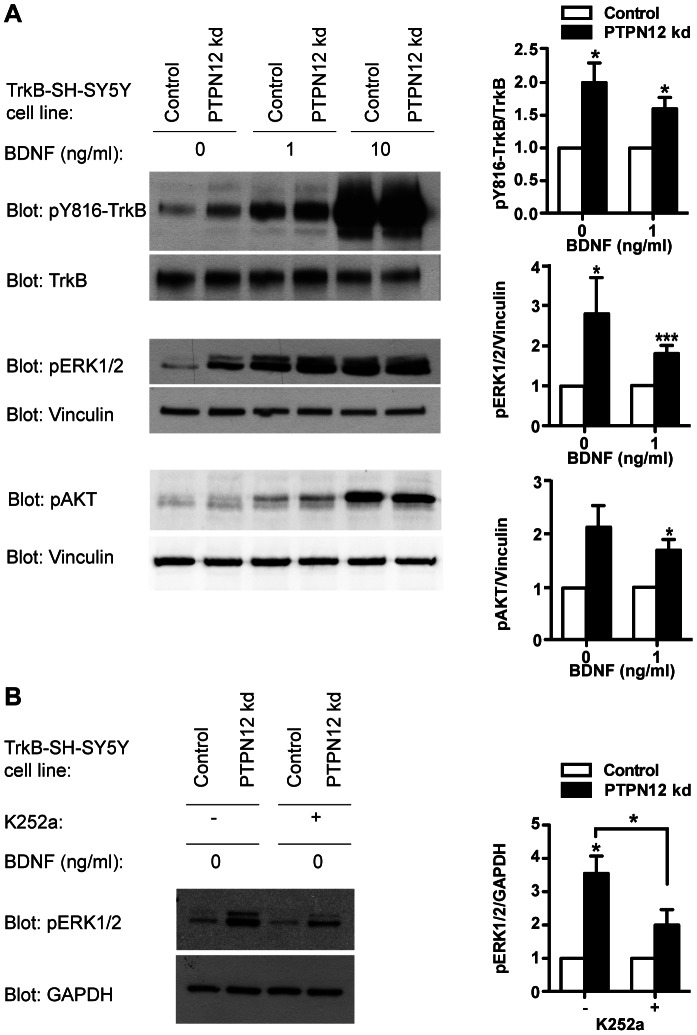
PTPN12 modulates TrkB signaling in TrkB-SH-SY5Y cells.A) Western blot analyses for pY816-TrkB, TrkB, pERK1/2, pAKT and Vinculin levels in control and PTPN12 kd cells cultured for 24 h, starved for 4 h and stimulated for 5 min with 0, 1 or 10 ng/ml BDNF. Graphs show densitometric quantifications of pY816-TrkB compared to total TrkB, and pERK1/2 and pAKT compared to total Vinculin, for cells in absence of BDNF (basal level) or with 1 ng/ml BDNF (mean and S.E.M. of three, seven, and four independent experiments respectively). PTPN12 kd values were normalized to the level of the control for each BDNF concentration. NB: p-value = 0.076 for comparison of pAKT between control and PTPN12 kd both at 0 ng/ml BDNF. B) PTPN12 kd and control cells cultured as in A) in the absence of BDNF ± K252a were analyzed for pERK1/2 levels using GAPDH as a reference. Respective densitometric quantifications are shown as mean and S.E.M. of three independent experiments; PTPN12 kd is normalized to the level of the control in the absence or presence of K252a. Statistical analyses were performed using Student’s paired t-test comparing control and Ptpn12 kd, except where otherwise specified (*: p≤0.05; ***: p≤0.005). NB: p-value = 0.060 for comparison of pERK between control and PTPN12 kd both treated with K252.